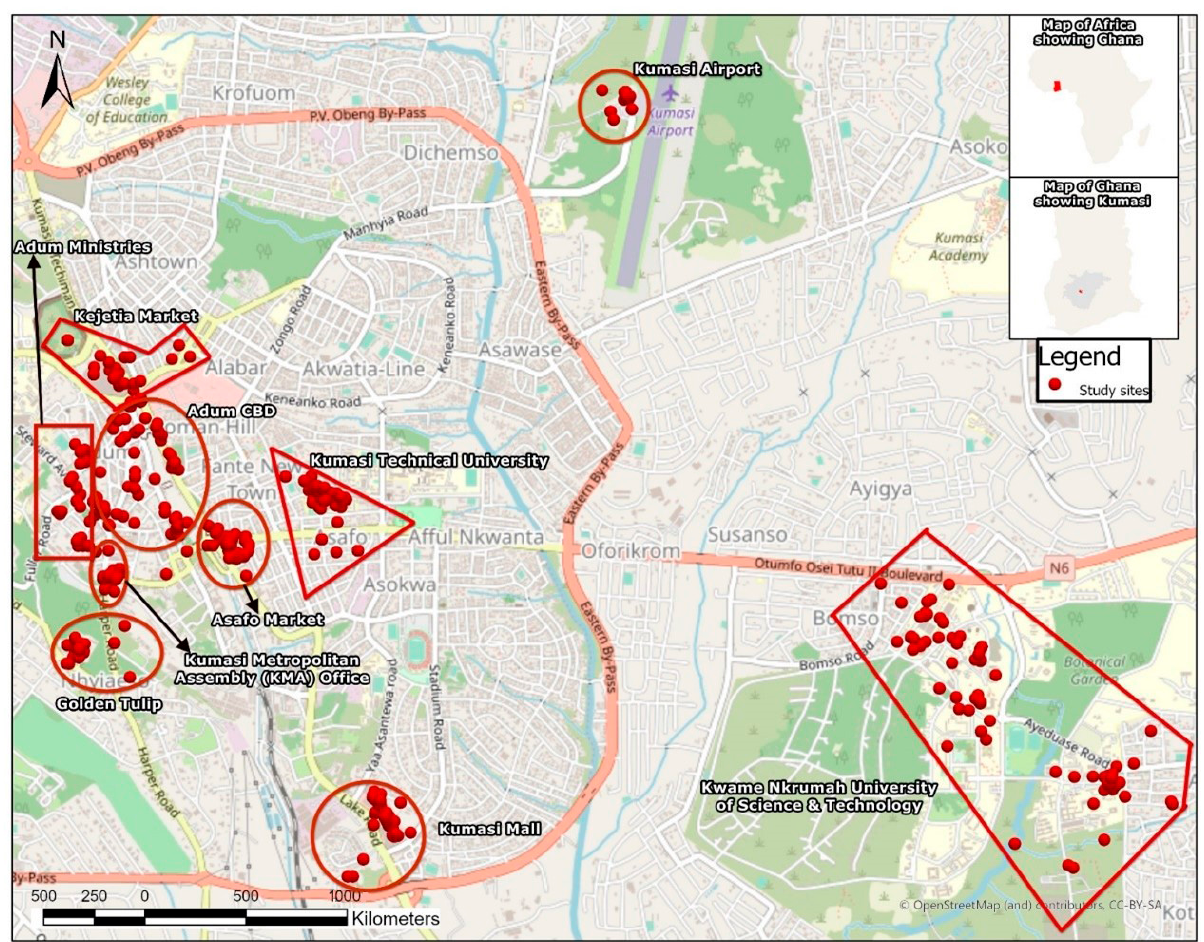
Figure 2. An annotated map of study sites in Kumasi .